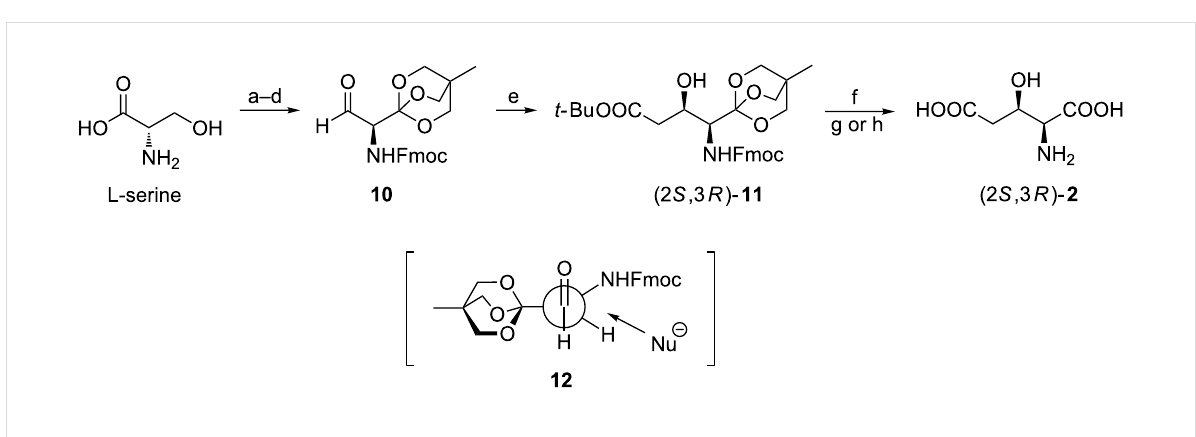
Scheme 3: Two-carbon homologation of the protected L-serine. Reagents and conditions: a) Fmoc-succinimide, Na 2 CO 3 , dioxane, H 2 O; b) (3-hydroxymethyl)-3-methyloxetane, DCC, DMAP, CH 2 Cl 2 ; c) BF 3 · OEt 2 , CH 2 Cl 2 ; d) oxalyl chloride, DMSO, DIPEA, CH 2 Cl 2 ; e) BrCH 2 COO t -Bu, Zn,